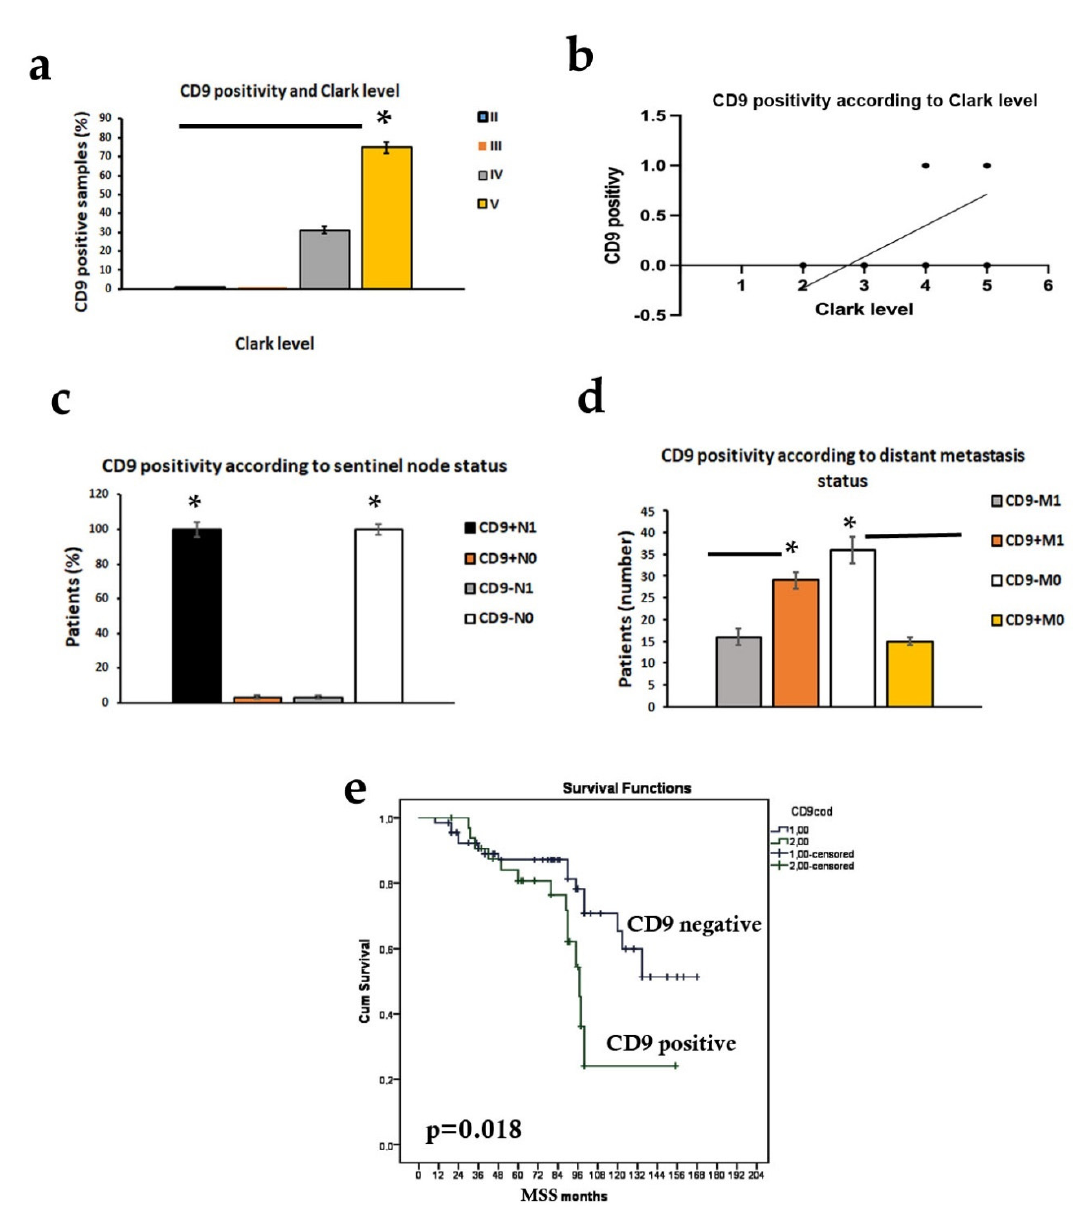
Figure 5. ( a ) Statistical representation of CD9 expression according to Clark level. CD9 staining was lost in II and III Clark levels and re-expressed in IV and V levels (* p < 0.05). ( b ) Correlation between CD9 and Clark level ( p < 0.001; r = 0.753, Spearman rank correlation). ( c , d ) Statistical representation of CD9 expression according to sentinel node and distant metastasis status (* p < 0.001); CD9+, positive to CD9; CD9-, negative to CD9; N0, sentinel lymph node negative; N1, sentinel lymph node positive; M0, absence of distant metastasis; M1, presence of distant metastasis. ( e ) Kaplan–Meier survival curves showed a significant association between CD9 expression and melanoma specific survival in patients with melanoma ( p = 0.018).